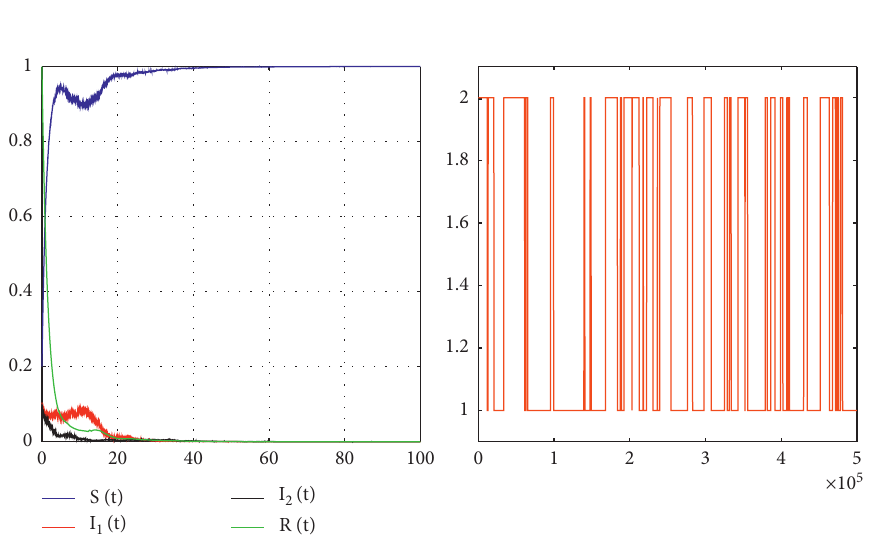
Figure 2: Sample paths of S ( t ) in blue, I